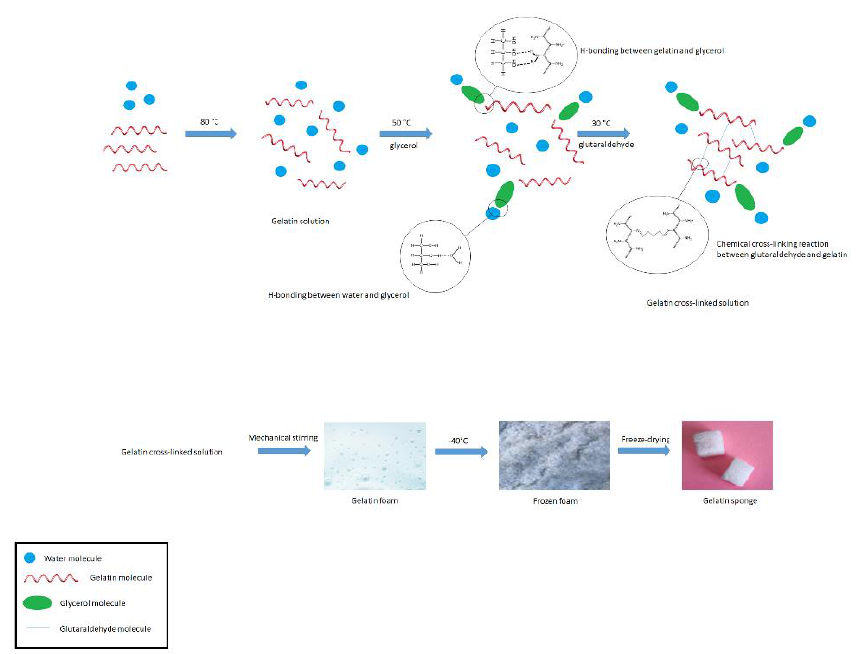
Figure 1. A scheme for the reaction